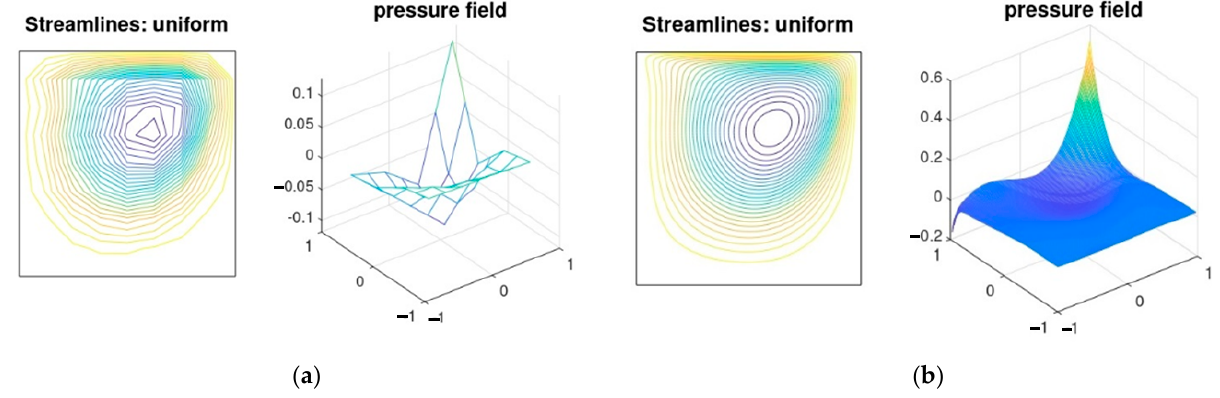
Figure 5. Equally distributed streamline plot associated with a 16 × 16 and 256 × 256 square grid, Q 2 – P 1 approximation. ( a ) 16 × 16 elements; ( b ) 256 × 256 elements. Figures 6–9 represent the errors, associated with a 16 × 16 and a 256 × 256 uniform square grid with a different element, Q 1 – Q 1 , Q 1 – P 0 , Q 2 – Q 1 , and Q 2 – P 1 .